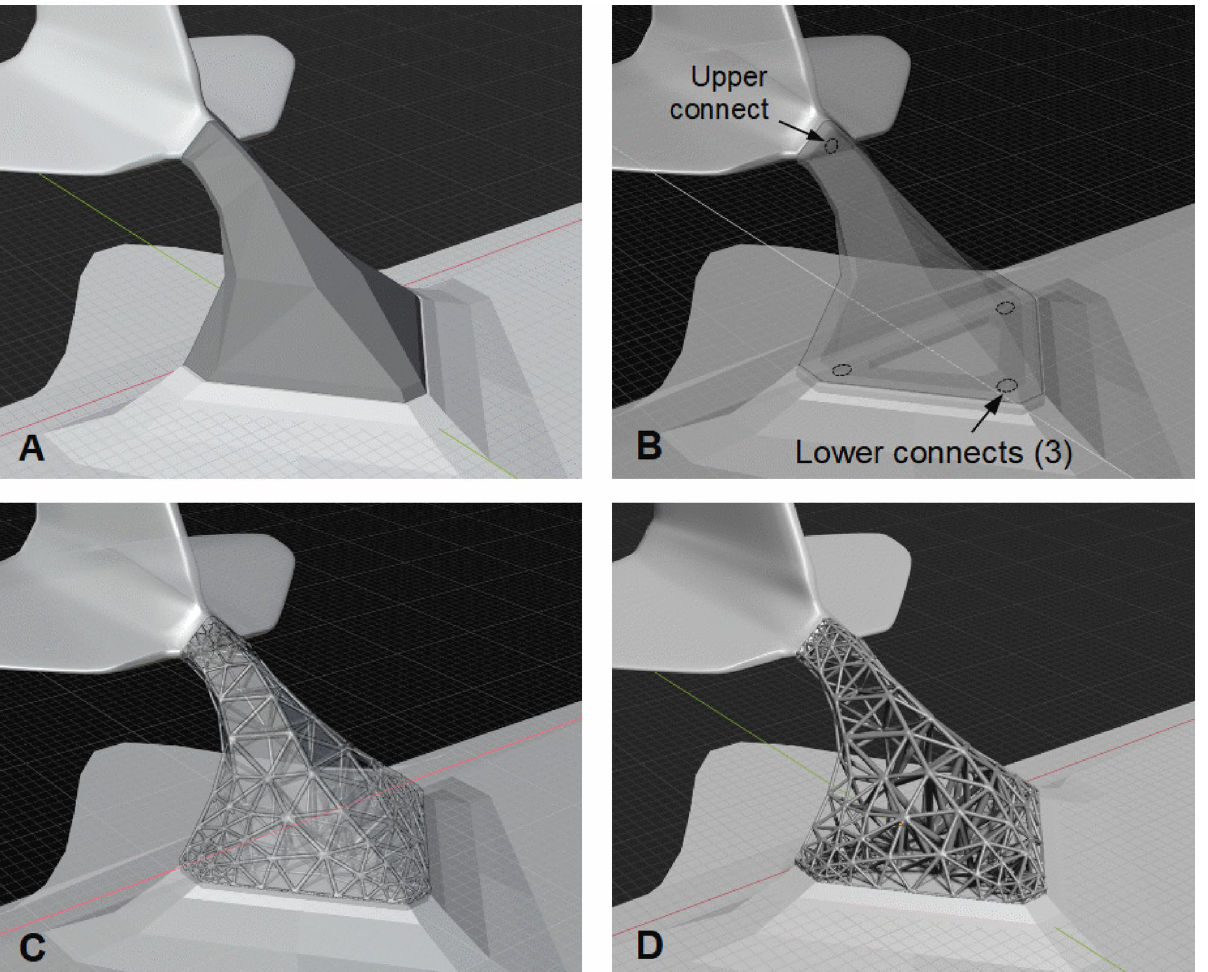
Figure 9. A multi-connected aerodynamic fin-panel support ( A ) original CAD surface/shell, ( B ) connecting holes, ( C ) conforming HGon and CAD superposed, and ( D ) lowest density HGon with minimum 2.4 mm strut diameter. The HGon is fully manifold and AM printed in aluminum or titanium (note the HGon is wrapped in mylar and carbon-fiber membrane for the final